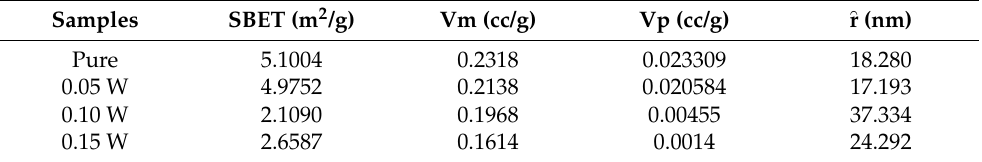
Figure 8. ( a ) BET plots, and ( b ) Pore-size distribution behavior of CoFe 2 O 4 (red colure), 0.5% W- CoFe 2 O 4 (blue colure), 0.1% W-CoFe 2 O 4 (olive colure), and 0.15% W-CoFe 2 O 4 (wine colure) of W- substituted CoFe 2 O 4 nanoparticles.